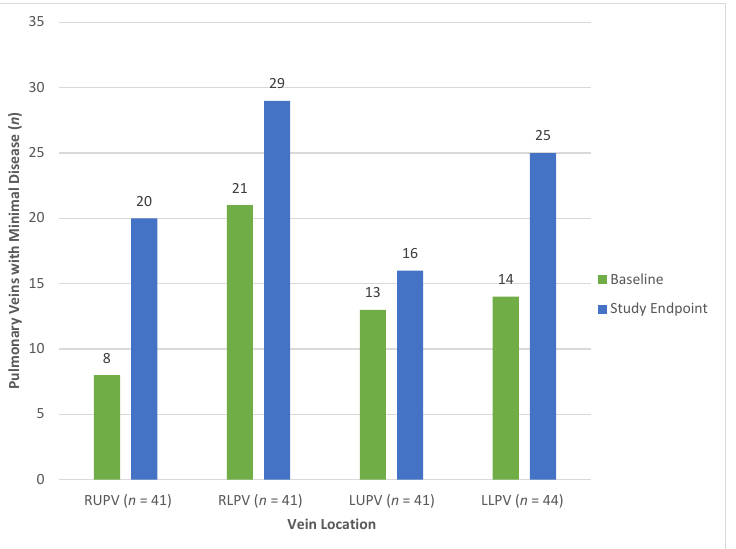
Figure 3. Number of individual pulmonary veins with minimal disease at baseline and the study endpoint. RUPV = right upper pulmonary vein, RLPV = right lower pulmonary vein, LUPV = left upper pulmonary vein, LLPV = left lower pulmonary